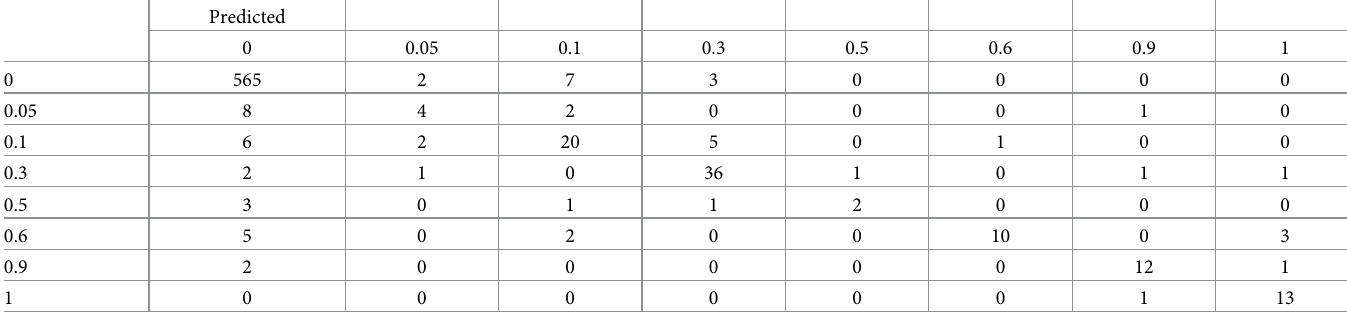
Table 2. Multinomial logistic regression prediction on the testing data set (70% training, 30% testing). Data was classified with respect to pathology gradings of the region the spectra were acquired from. Predicted